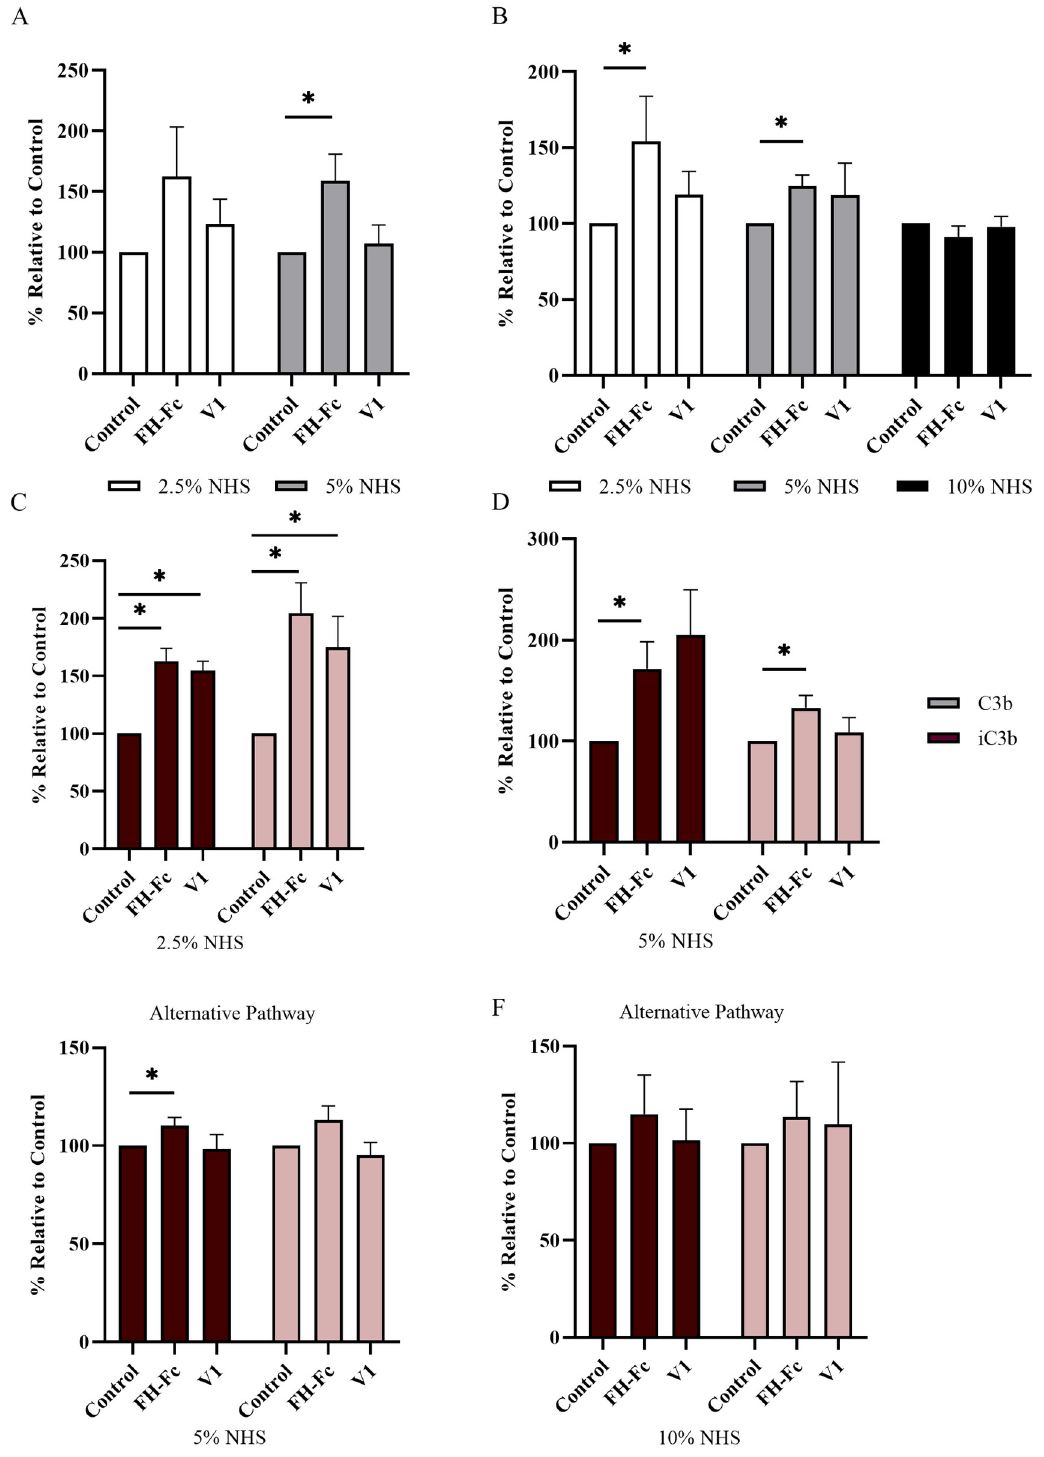
Fig 6. FH-Fc and V1 increase C3-fragment deposition of CA-MRSA R7. Bacteria (5 × 10 7 CFU) were incubated with or without 4.5 μ g fusion protein in various amounts of NHS for 30 minutes. Deposited C3-fragments were extracted and analyzed by ELISA (total C3) and Western Blot (C3b and iC3b). Total C3-fragment deposition for all complement pathways (A) and alternative pathway only (B). C-F, Western blot semi-quantification of samples tested in (A) and (B) presented as a percent relative to no-treatment control. Data represent mean ± SEM of at least 3 independent experiments; � p < 0.05.